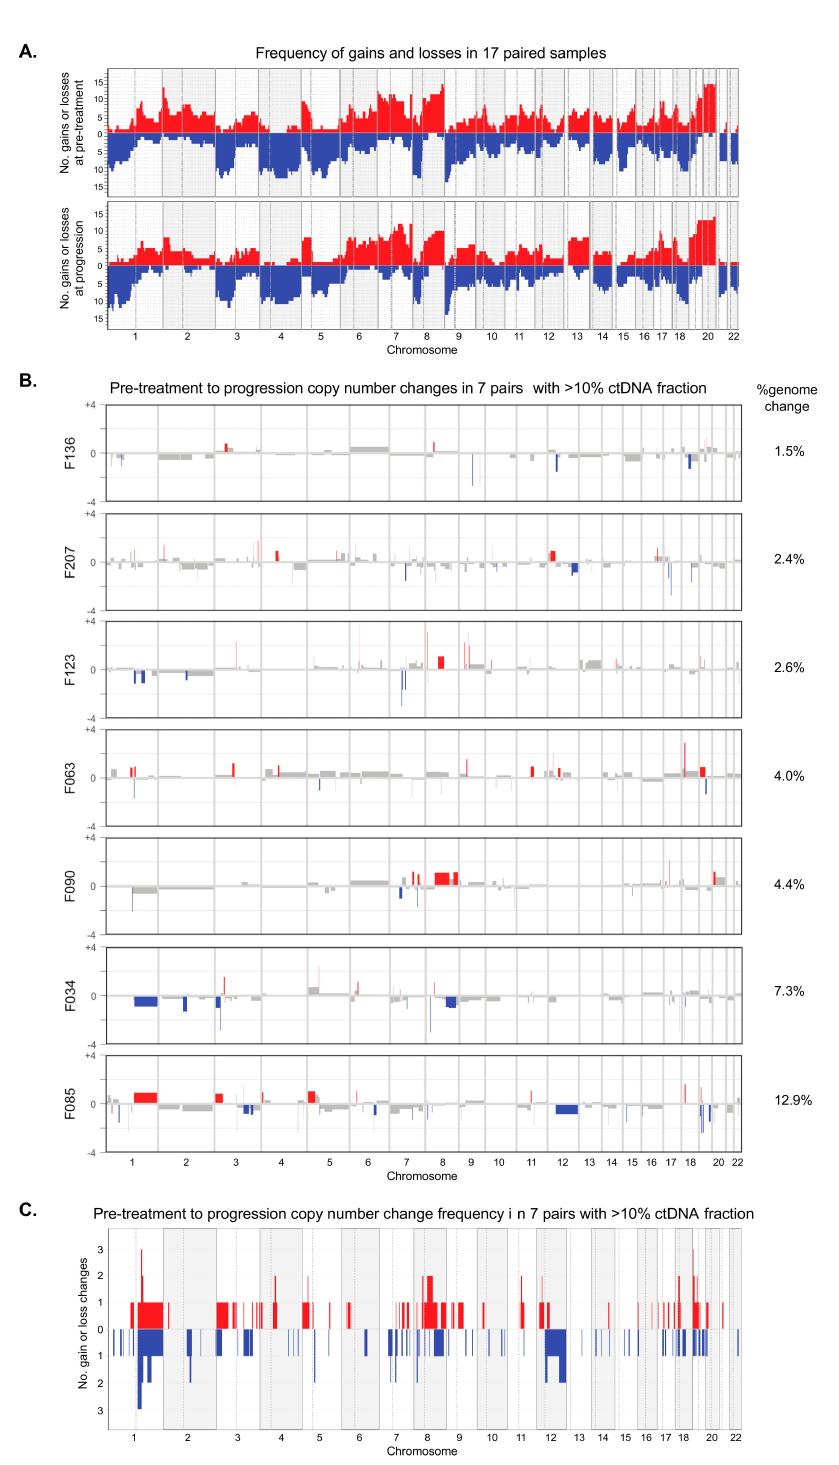
Figure 4. ( A ) Frequency plots showing the number of cases ( n = 17) that show segment gains (red) or losses (blue) at pretreatment (top) and at progression (bottom). ( B ) For 7 pairs where both samples had > 10% ctDNA fractions, comparative plots show absolute copy number gains and losses at progression relative to pretreatment, ordered by the extent of genomic change. The percent genomic change for each sample is indicated to the right of each plot. Red = gain, blue = loss, and black = no change. A minimum of 0.8 copy number change was required to score a gain or a loss. ( C ) Frequency plot showing the number of cases ( n = 7) that show segment gains (red) or losses (blue) at progression relative to